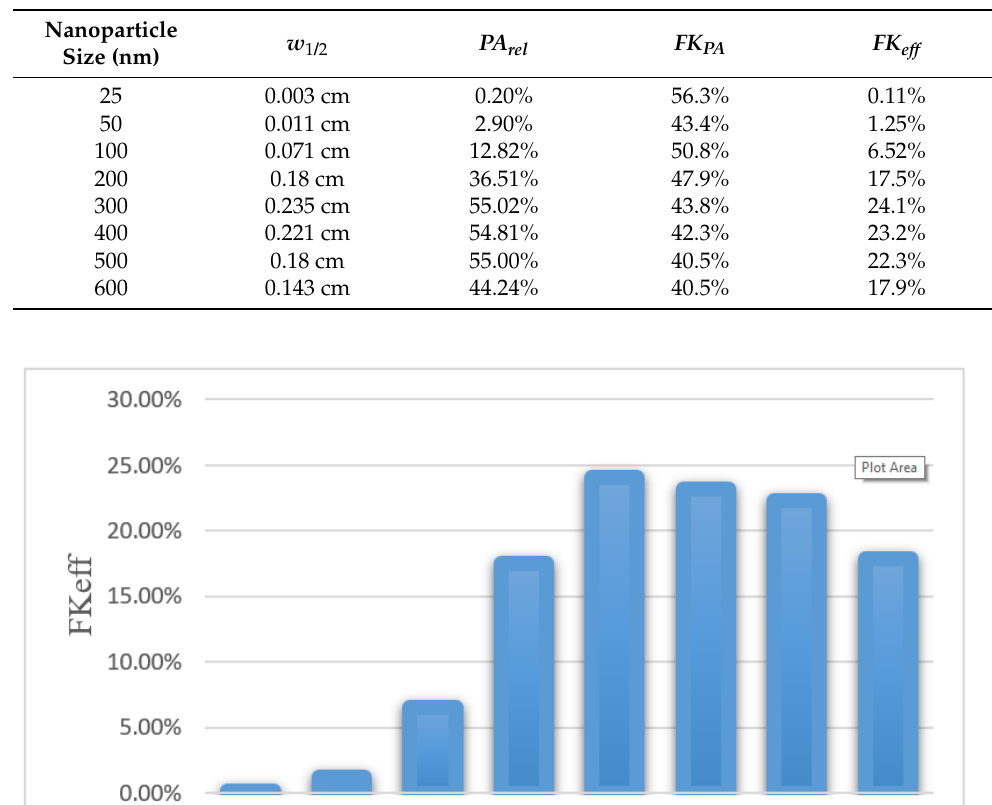
Figure 16. Comparison of the mean concentration of free drug ( C F ) in the tumor after 60 min of treatment for different applied magnetic